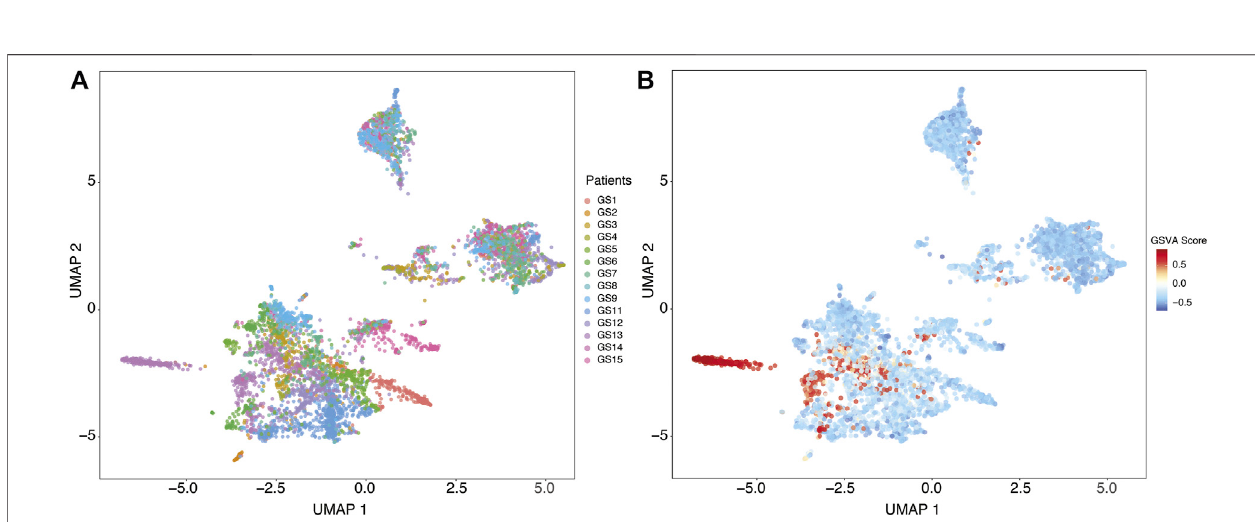
FIGURE3| Biclusters fromTuBA ’ slowexpression analysis,eitherenriched intheGTEx normaltissuecollectedfrom differentbrainregionorenriched intheTCGA tumors with LGG or GBM subtypes. The bars show the proportion of GTEx vs. TCGA samples in each bicluster. GTEx-speci fi c biclusters were enriched in cerebellum, cerebellar hemisphere, cortex, frontal cortex, or anterior cingulate cortex, while all TCGA-speci fi c biclusters were enriched in GBM tumors.